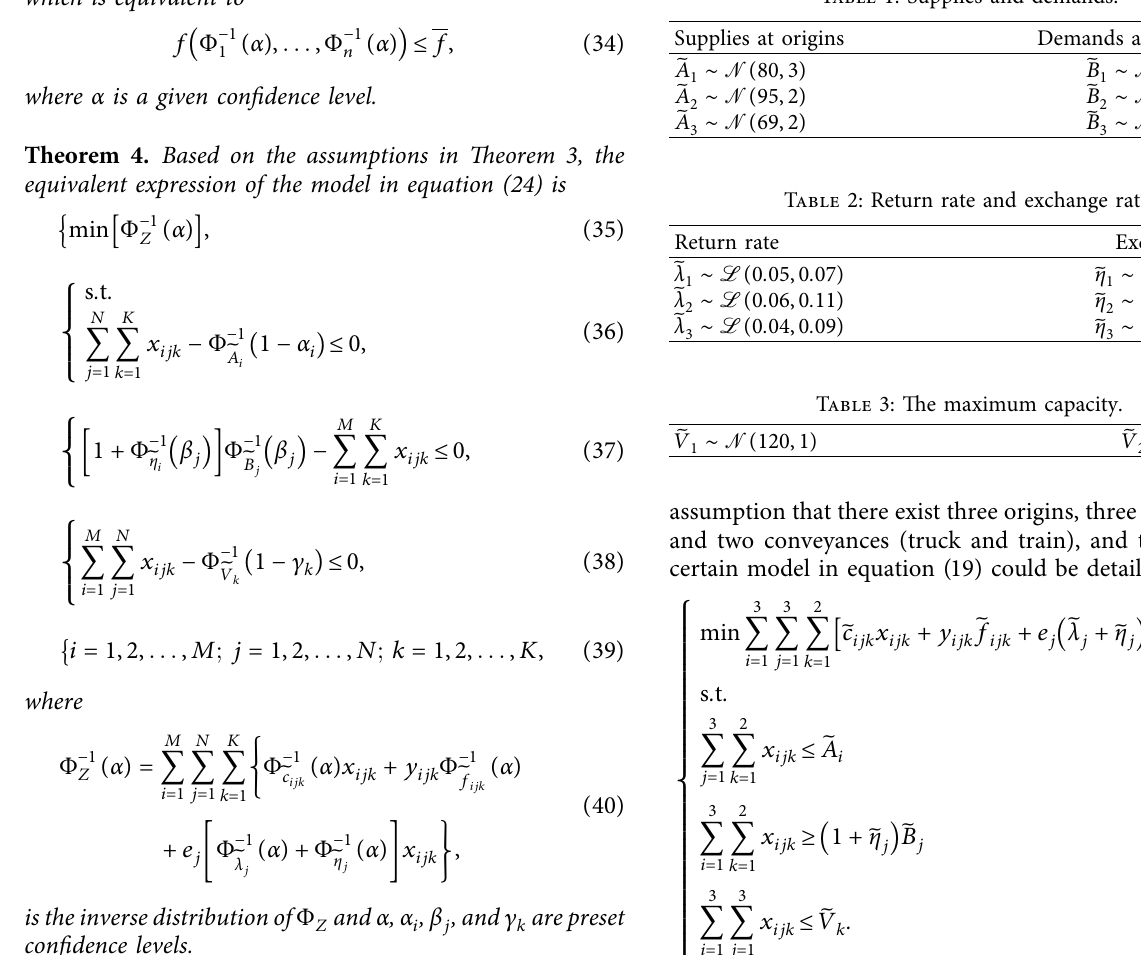
Table 1: Supplies and demands.